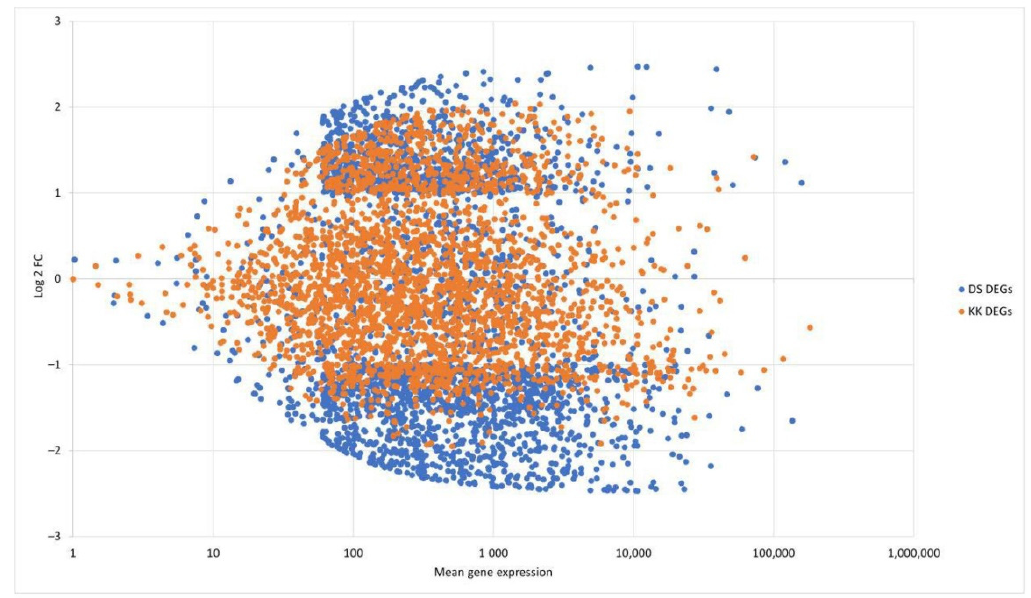
Figure 1. Up- and downregulated genes in KK and DS pepper cultivars in response to PSTVd infection at 43 dpi. The expression of twice as many genes was affected by viroid infection in DS than in